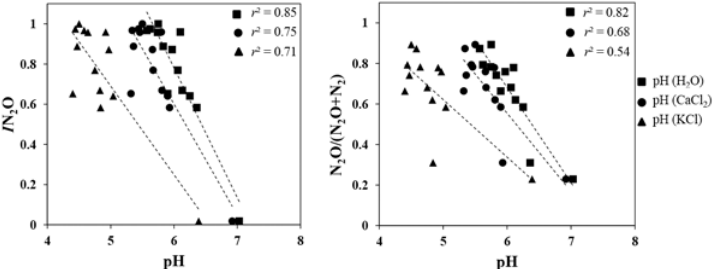
Fig 4. Relationship between pH and N 2 O emissions. Effect of method (extractant type) for determining soil pH on association with (a) N 2 O production index ( I N 2 O) and (b) N 2 O/(N 2 O+N 2 ) ratio. Calculation of both index and ratio was based on N 2 O emission within the curve (see S1 Fig for each sample) at 50 h under anoxic incubation. Soil pH was measured using three different extractants: i) DI water, ii) 0.01 M CaCl 2 , and iii) 2M KCl. Dotted lines represent regression lines. Points represent the mean triplicate flask